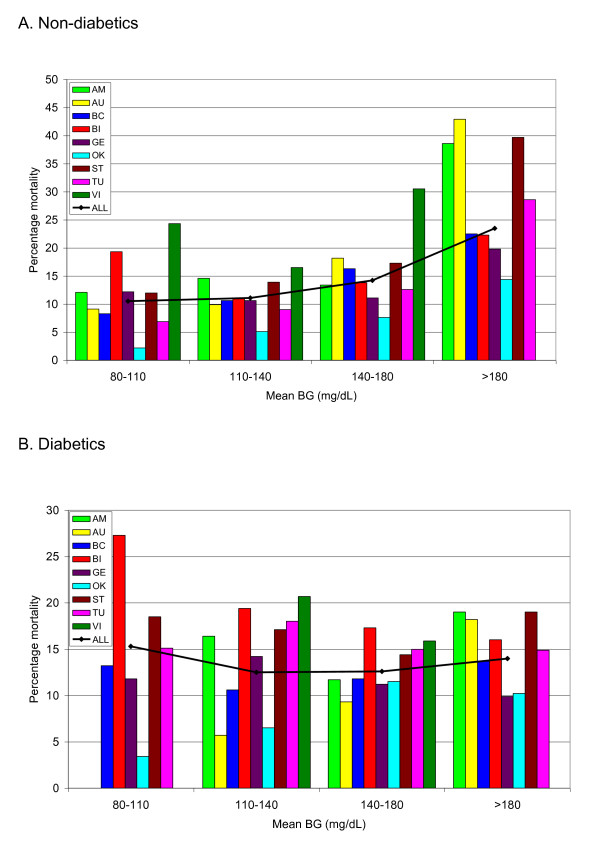
Mean blood glucose (BG) and mortality. The relation of mean BG
(milligrams per deciliter) during ICU stay to mortality in those without
(A) and those with diabetes (B), for each of the nine
cohorts as well as the entire population.